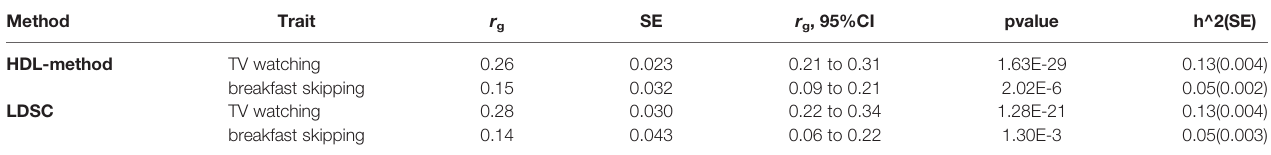
TABLE 1 | Genetic correlation of type 2 diabetes with TV watching and breakfast skipping, estimated by high-de fi nition likelihood method (HDL-method) and linkage disequilibrium score regression (LDSC). Method